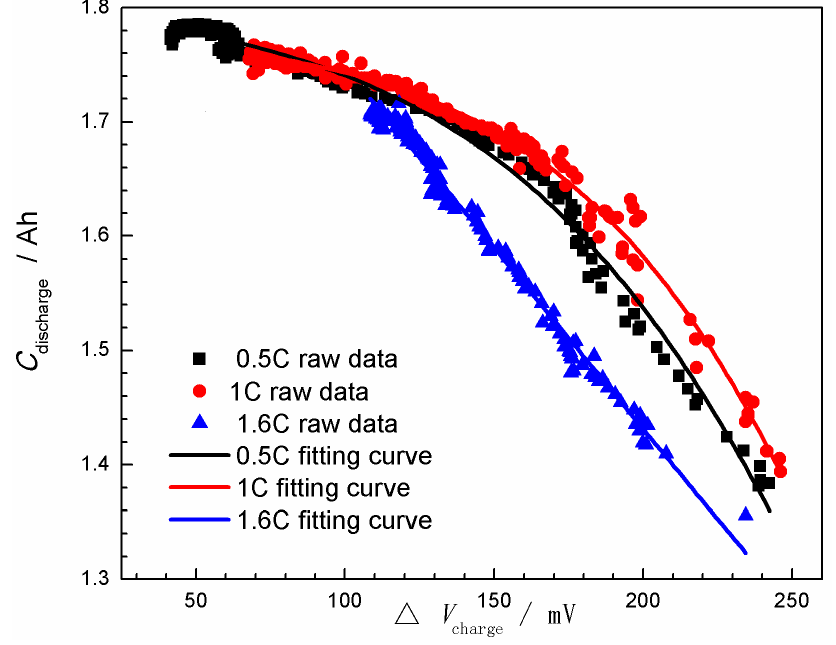
Figure 3. ( C discharge , ∆ V charge ) raw data at different rates and their fitting curves with Equation (2). Table 1. Fitting parameters of a , c , and k for different Ni-MH cells at different rates.